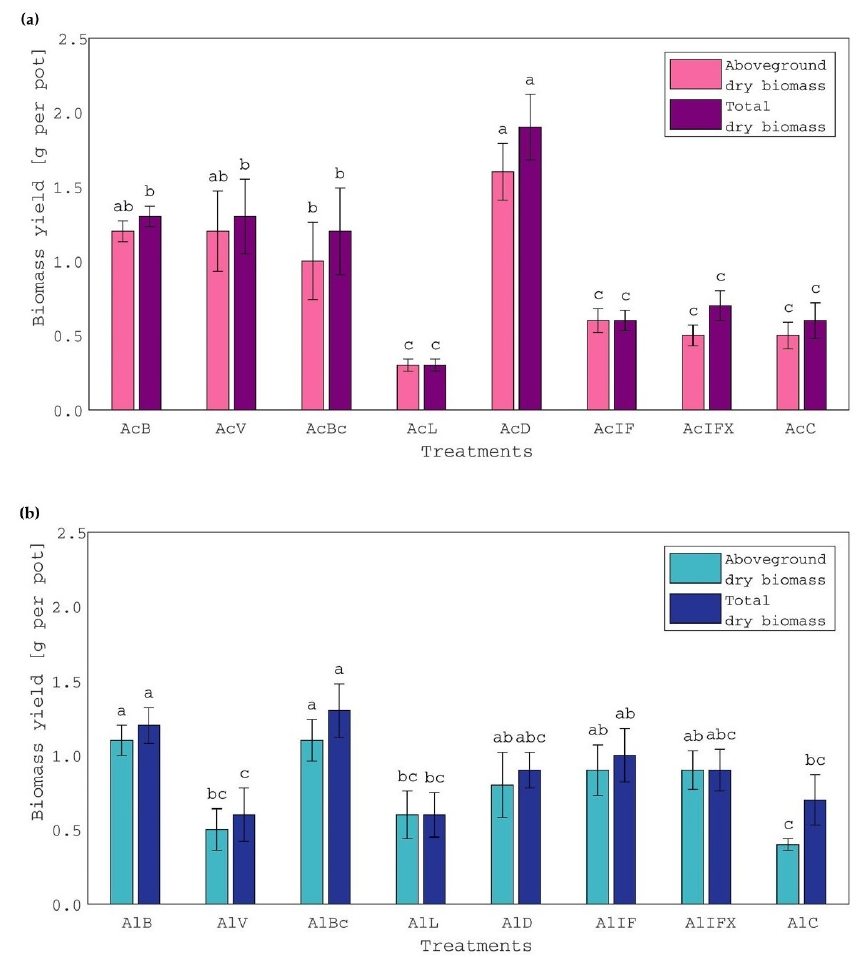
Figure 1. Aboveground and total dry biomass yield of white clover plants, grown in ( a ) acid soil treatments and ( b ) alkaline soil treatments. Treatment of the acid and alkaline soil, respectively, with: AcB and AlB: bentonite-treated sludge; AcV and AlV: vermiculite-treated sludge; AcBc and AlBc: biochar-treated sludge; AcL and AlL: limed sludge; AcD and AlD: air-dried sludge; AcIF and AlIF: N-P-K inorganic fertilization; AcIFX and AlIFX: P-K inorganic fertilization; AcC and AlC: control. Different letters, within each soil and property, indicate significant differences among means, using the LSD test, at p ≤ 0.05.